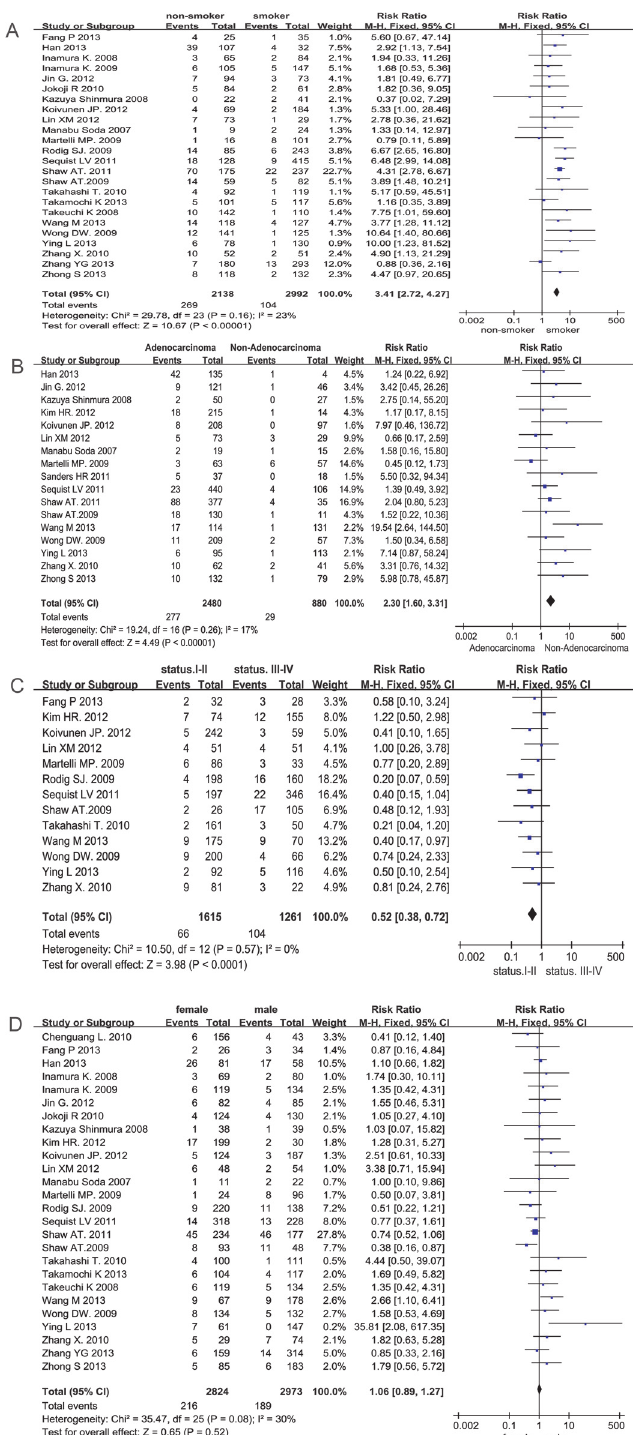
Fig 2. Meta-analysis of data for EML4-ALK. (A smokers vs no-smokers; B adenocarcinomas vs non- adenocarcinomas; C stages I-II vs stages III-IV; D male vs female). Forest plot of the Relative Risk (RR) of the clinicopathological characteristics with EML4-ALK fusion gene patients. The RR estimate of each individual trial corresponds to the middle of the squares and the horizontal line gives the 95% CI. On each line, the numbers of events are represented as fractions of the total number; random choices are shown